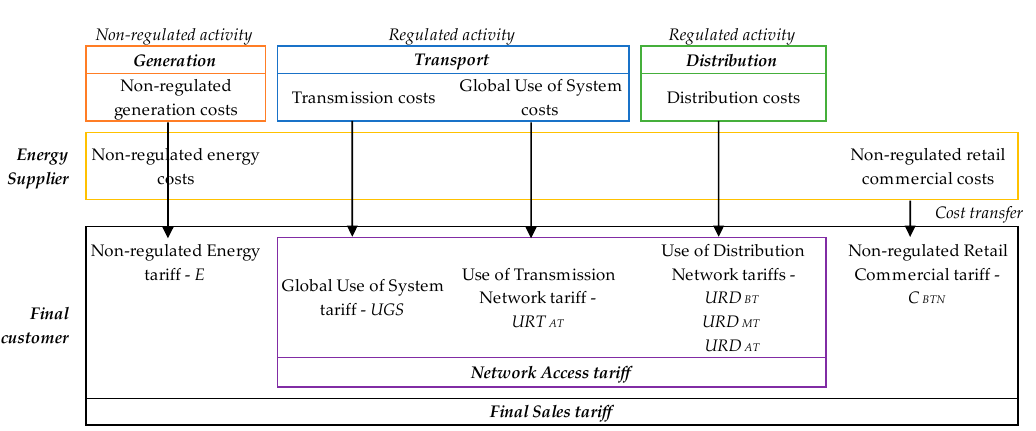
Table 1. Network Access tariff reductions applicable for surplus distributed electricity traded within low voltage P2P energy sharing communities.